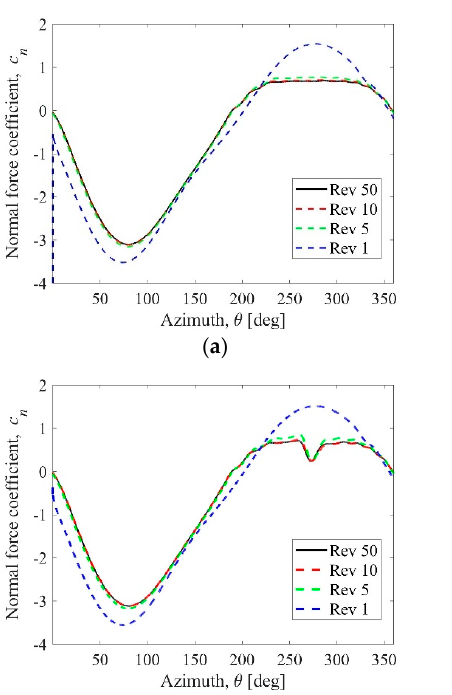
Figure 11. Aerodynamic forces for example rotor rotations. ( a ) Normal force coefficient for clean rotor; ( b ) Tangential force coefficient for clean rotor; ( c ) Normal force coefficient for the shafted rotor; ( d ) Tangential force coefficient for the shafted rotor.